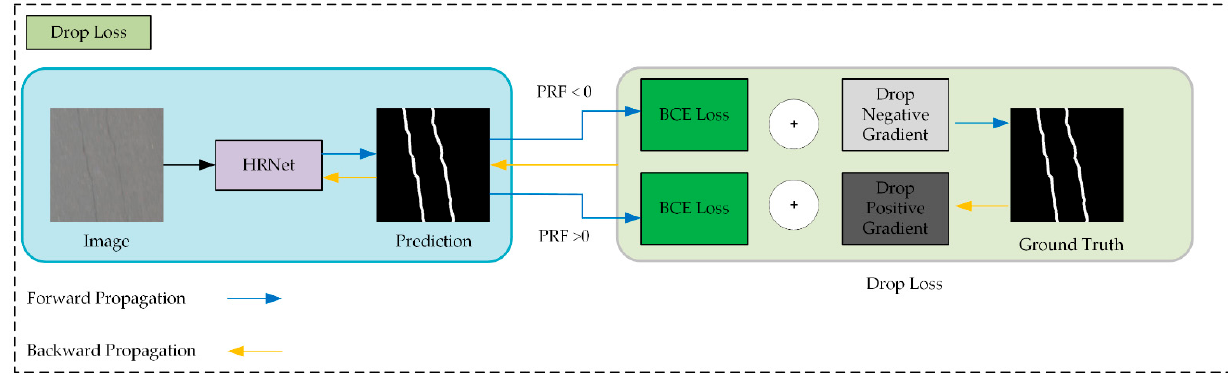
Figure 3. Schematic diagram of the drop loss.